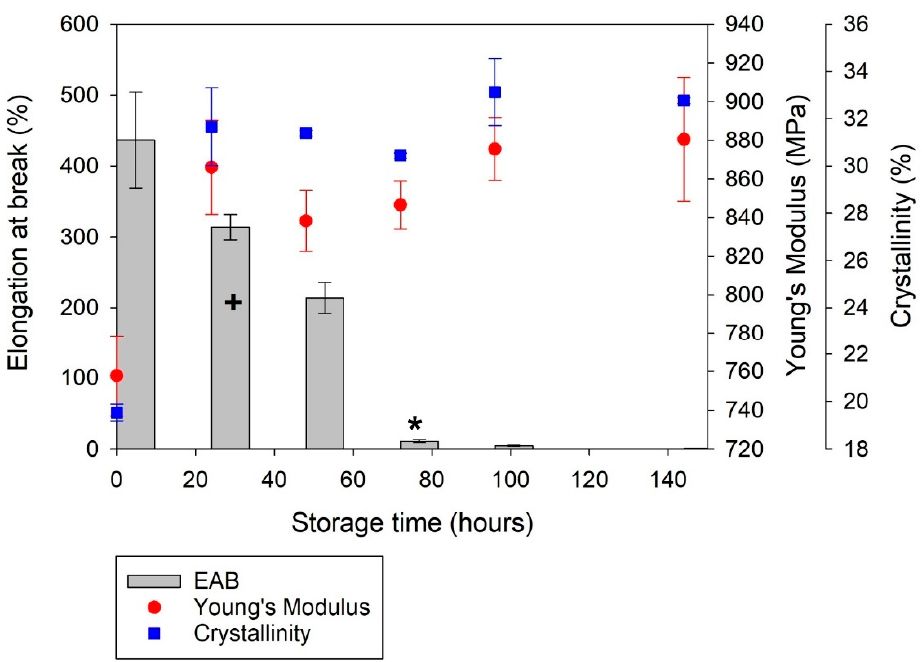
Figure 10. The change in elongation at break (EAB) Young’s modulus, and crystallinity of PA-12 plaques with increased storage time. + Significant change in EAB when compared to the 0 h sample ( p < 0.05). * Very significant change in EAB when compared to the 0 h sample ( p < 0.005).